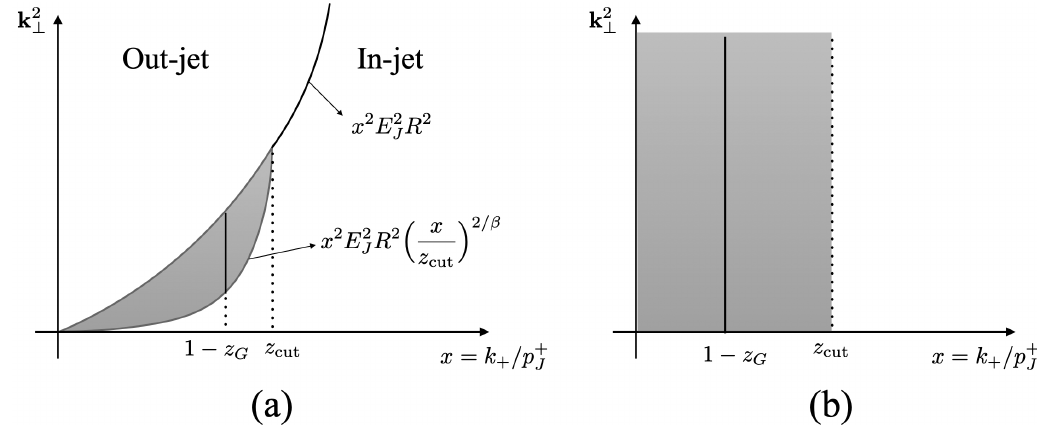
Figure 6 . Diagram (a) is the phase space of the csoft gluon in the one-loop calculation of Φ G for E J R & m . Diagram (b) denotes the phase space for the ultra-collinear soft (ucsoft) gluon radiation when we consider the limit E J R (cid:29) m for Φ G applying the soft drop with β = 0 . Both the shaded regions denote the groomed region, where the radiated gluon is dropped by the soft drop